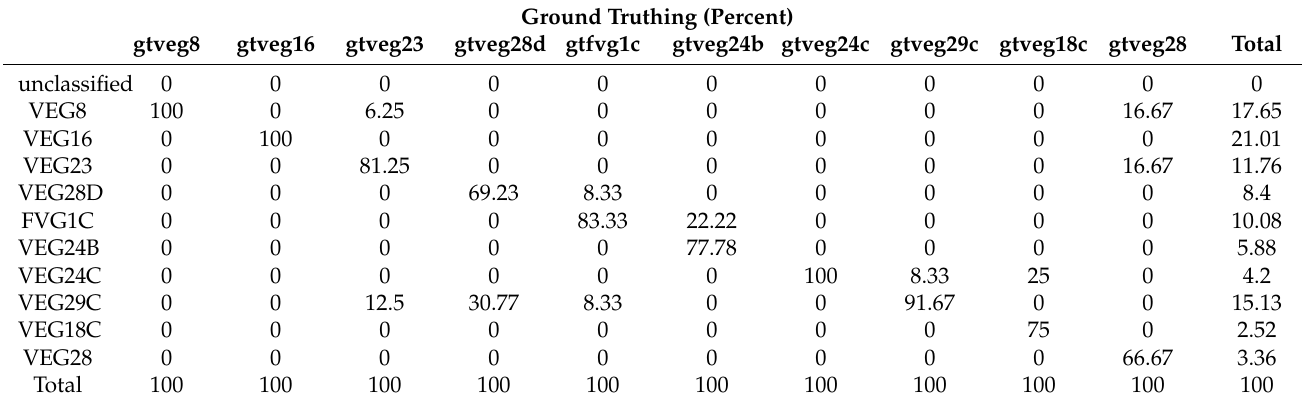
Table A5. Confusion matrix accuracy assessment output showing how the ground truthing ROIs were assigned by the classifier.